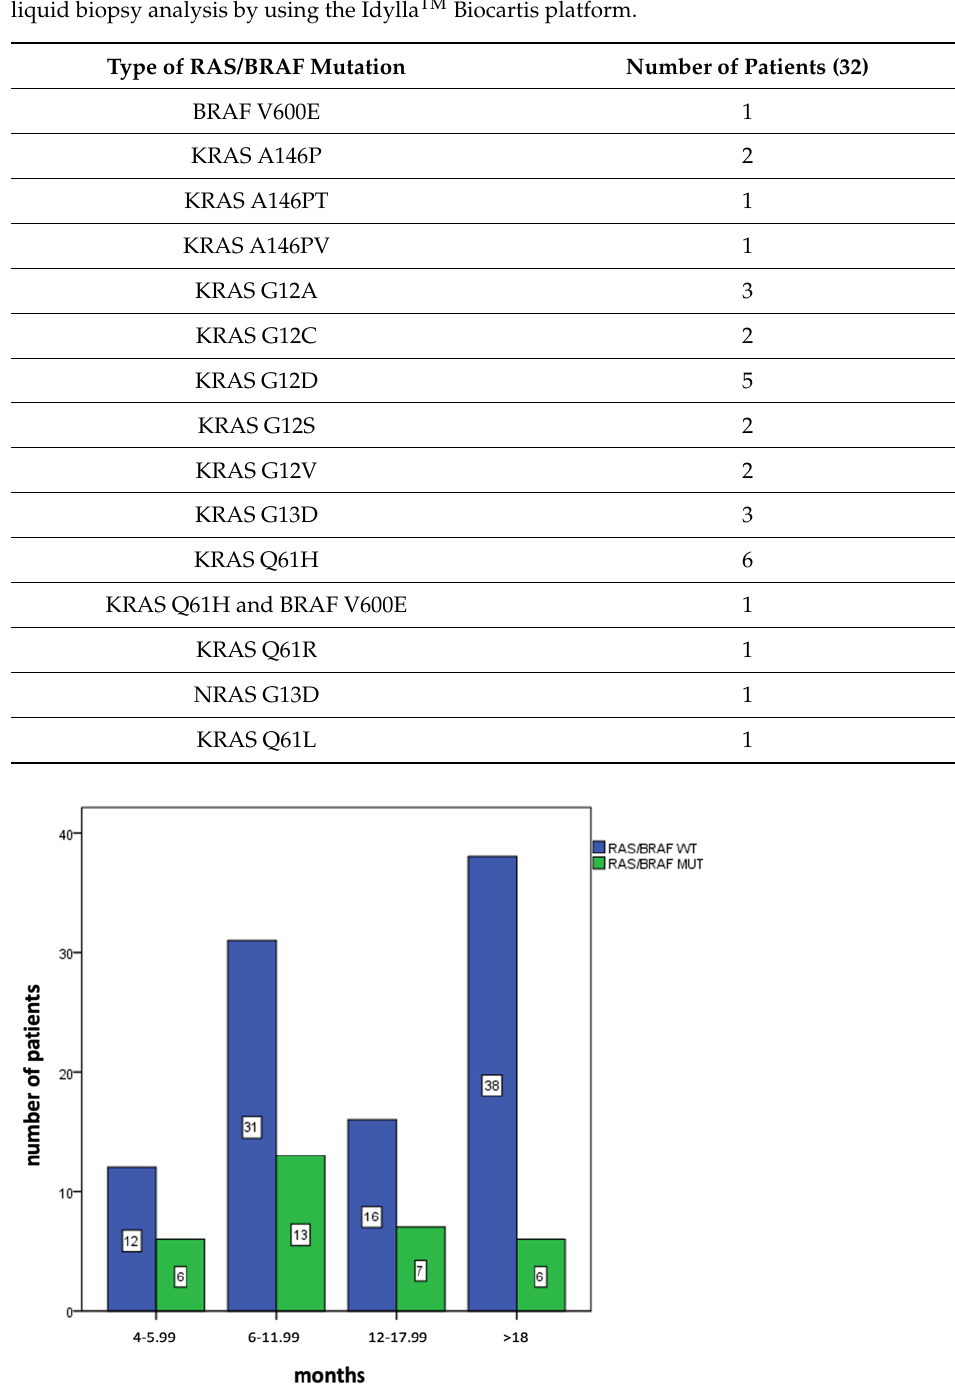
Figure 3. Descriptive analysis of RAS / BRAF mutational status in different subgroups depending on the length of the anti-EGFR free interval that was calculated as the time from the last anti-EGFR administration and baseline evaluation before study treatment in the CAVE and VELO clinical trials.